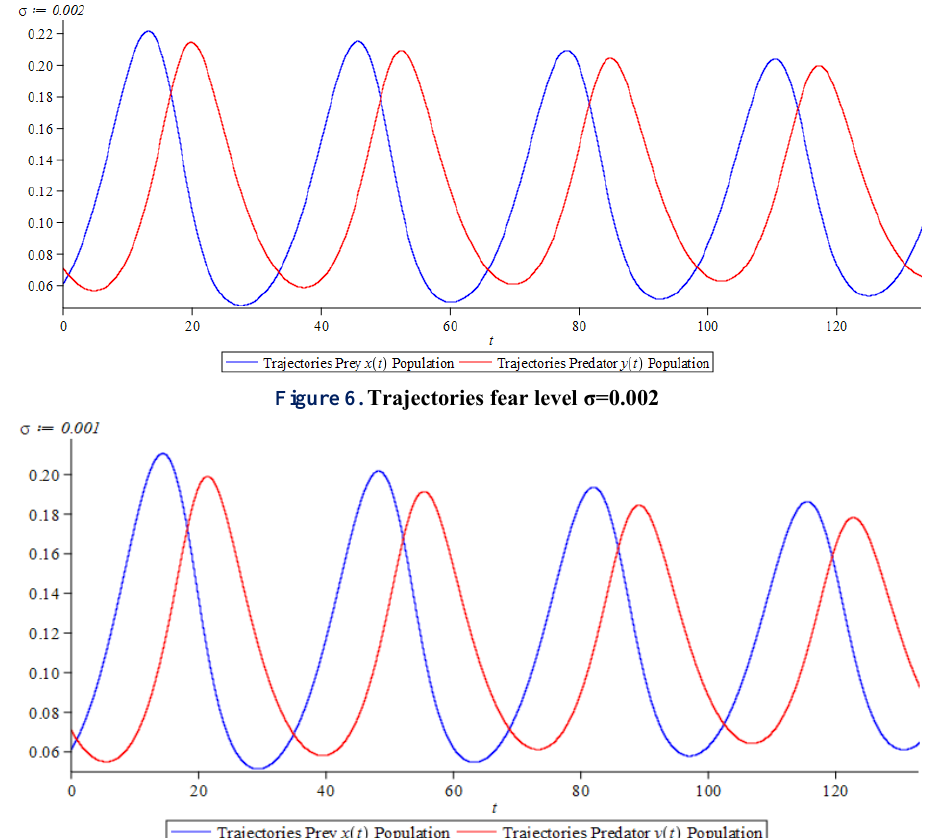
Figure 7. Trajectories fear level